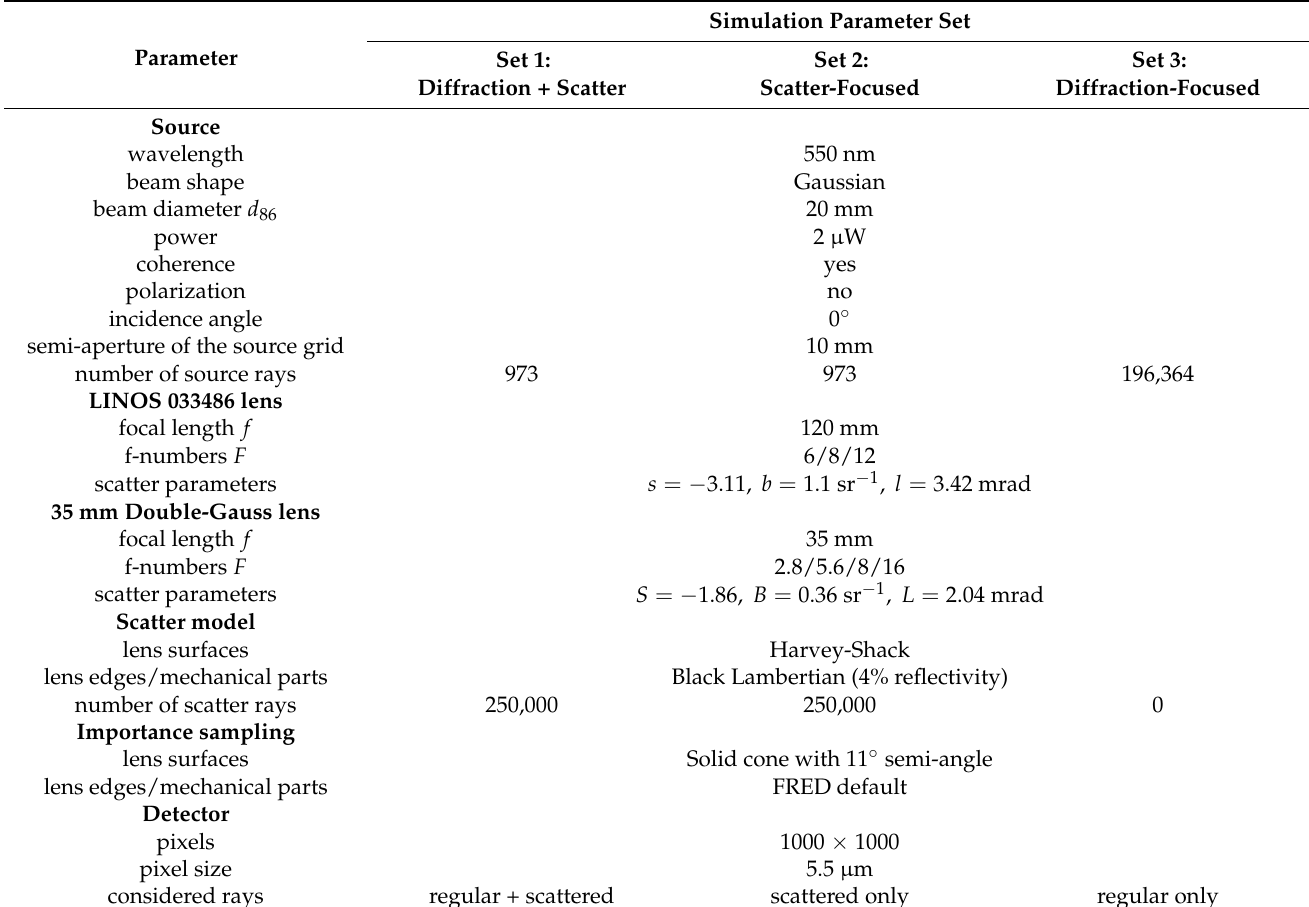
Table 3. Parameter sets for the FRED software to simulate the irradiance distribution at the focal plane of camera